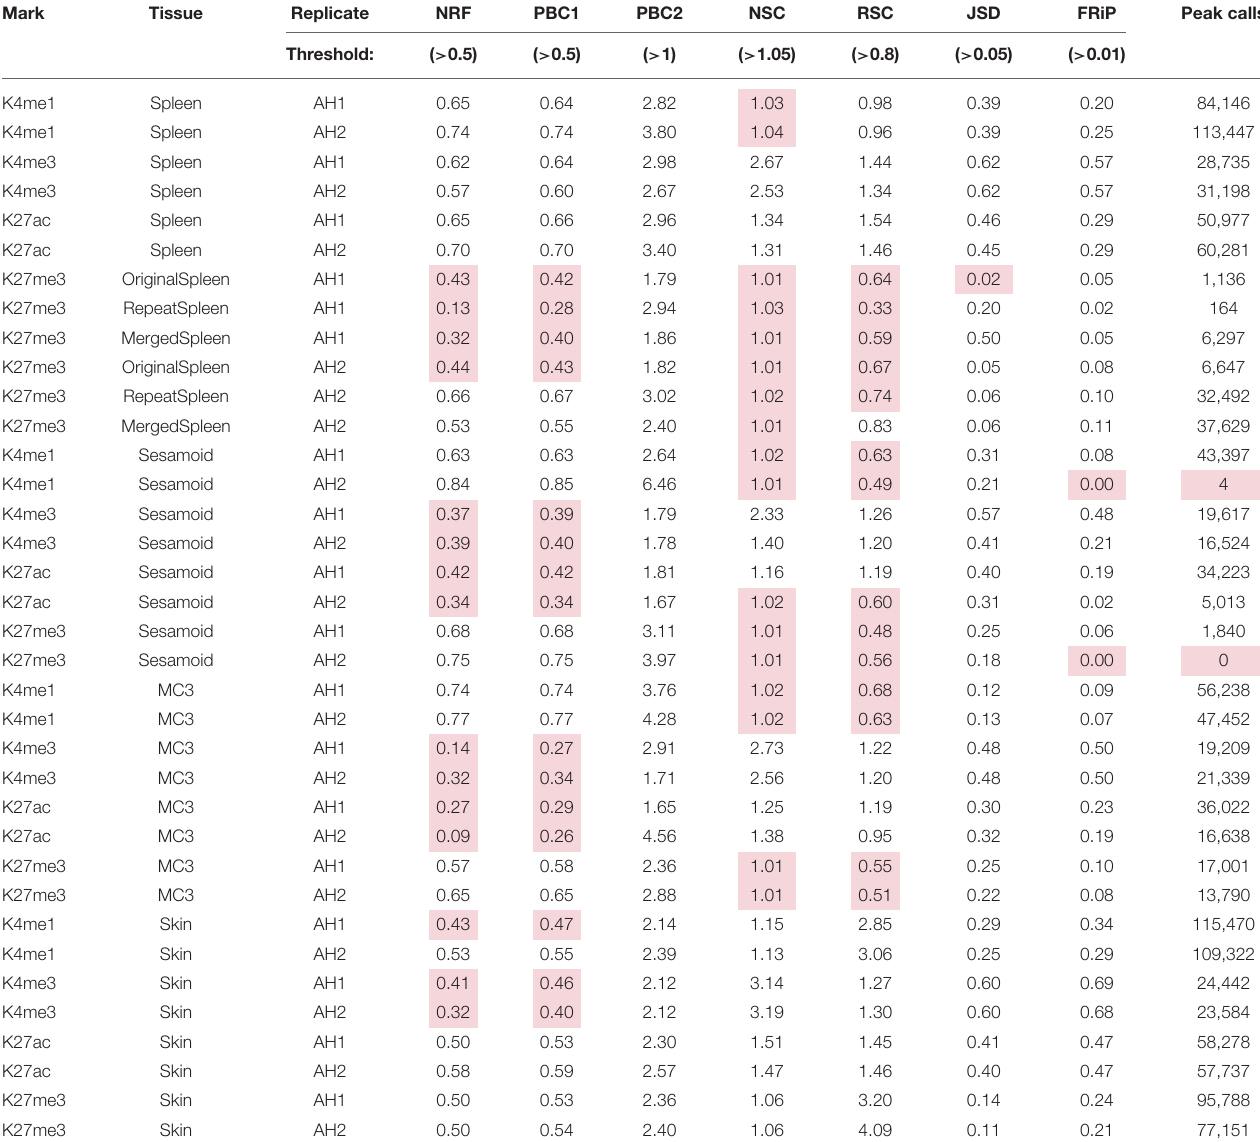
TABLE 1 | Quality metrics and peak-calling summary for each biological replicate.